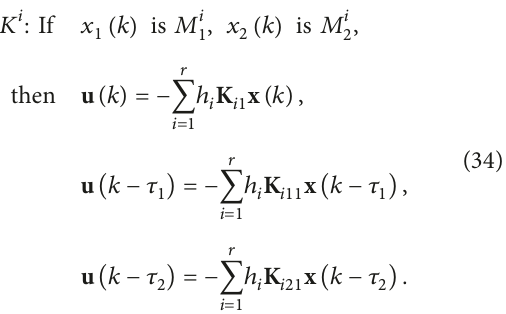
Figure 4: Evolution processes of inventory level under the fuzzy robust 𝐻 ∞ control